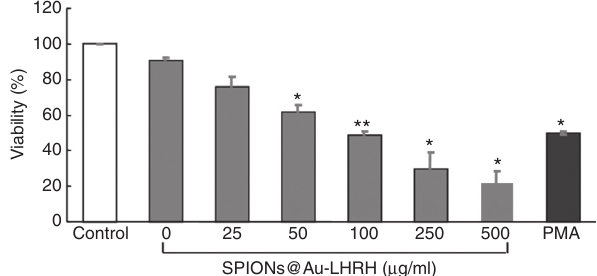
Figure 5 Viability of GT1-7 neurons following the second time exposure to magnetic field. GT1-7 neurons were pretreated with SPIONs@Au-LHRH (25–500 μ g/ml) for 24 h and then exposed to a magnetic field strength of 465 Oe (2 × 15 min). The metabolic activ- ity of cells was measured using a resazurin reagent, as described in the text and legend to Figure 3. Data presented are the change of % viability with respect to the untreated controls (i.e., without SPIONs@Au-LHRH pretreatment and exposure to the magnetic field). The yields of resorufin in these controls were at 100%. Data presented are mean ± SD of three to five independent experiments (* and ** indicate significance at p < 0.05 and p < 0.01 versus untreated controls).